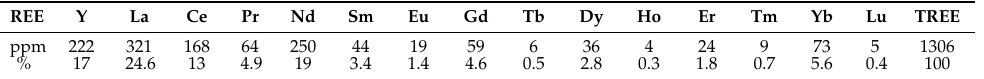
Table 3. Individual REE content and relative REE distribution in ore